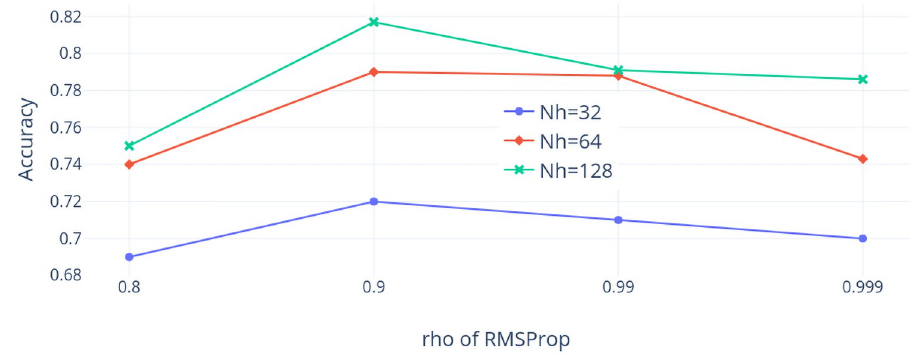
Fig 14. Accuracy with ρ varied (TX dataset).